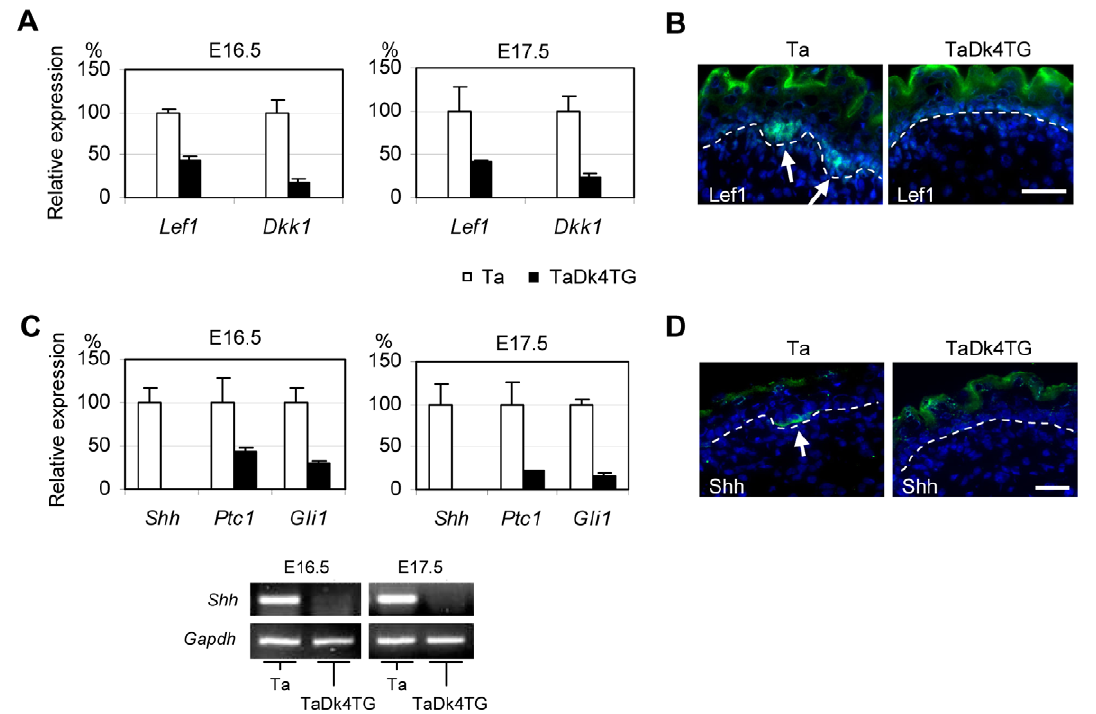
Figure 6. Wnt and Shh pathway genes were significantly downregulated in TaDk4TG skin. A, Q-PCR assays confirmed the significant downregulation of Wnt effector Lef1 and Wnt target Dkk1 in TaDk4TG skin at E16.5 and E17.5. B, Immunofluorescent staining revealed a nuclear localization of Lef1 protein in hair follicle germs in Tabby skin at E17.5 (arrows), but not in TaDk4TG skin. Scale bar, 50 m m. C, Shh was undetectable, and Ptc1 and Gli1 were significantly down-regulated, in TaDk4TG skin at E16.5 and E17.5, as assessed by Q-PCR (upper panels). Lower panels, electrophoresis of Q-PCR products after 40 cycles of amplification confirmed the absence of Shh in TaDk4TG. D, Shh protein was localized in the membrane and cytosol of the apical surface of hair follicle germs in Ta skin at E17.5, but was not seen in TaDk4TG. Scale bar, 50 m m. doi:10.1371/journal.pone.0010009.g006 fraction of the K14 promoter/beta-globin Intron/Dkk4 transgene/ (Fig. 1A). Microinjected embryos were implanted into pseudo- K14 polyA was cut out by EcoRI and HindIII, purified, and pregnant female mice. Genotyping was done by PCR with primers microinjected into pronuclei of one-cell C57BL/6J mouse embryos spanning Intron 2. Forward: CTCGCTGTGTGCATCA GACA.